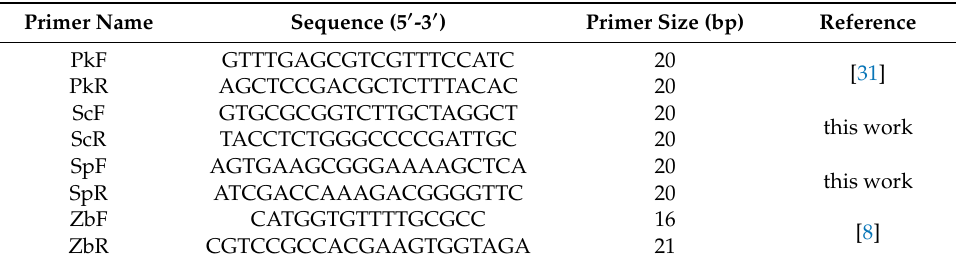
Table 1. Primers used for microbial population analysis in four yeast strains.